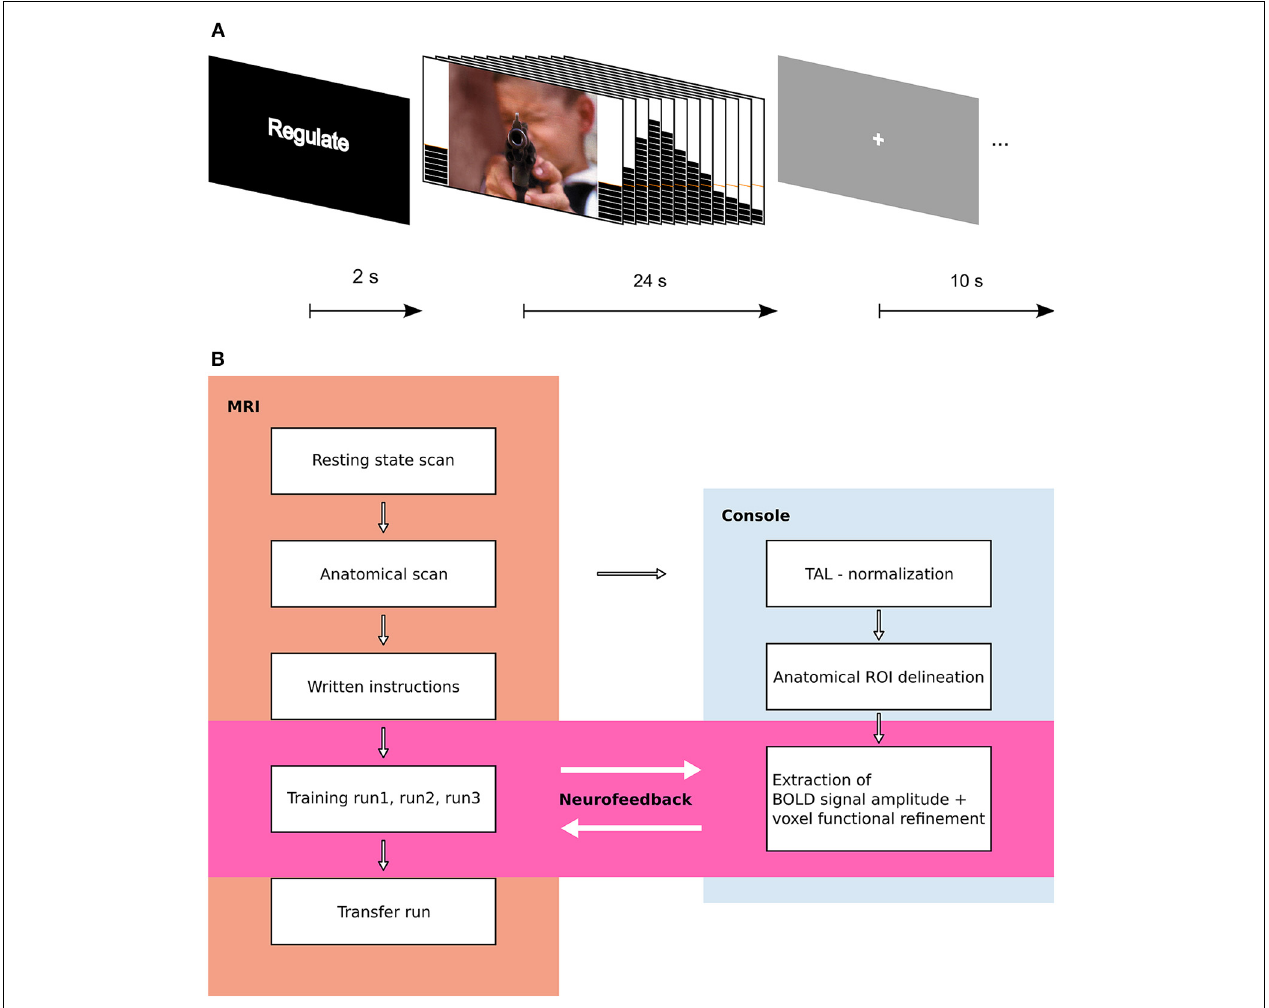
FIGURE 1 | Experimental design. (A) Trial structure. A trial started with a 2s instruction slide indicating trial type (REGULATE, VIEW, NEUTRAL). In the following block, participants either saw an aversive or a scrambled picture with a thermometer at both sides. The thermometer displayed the change in